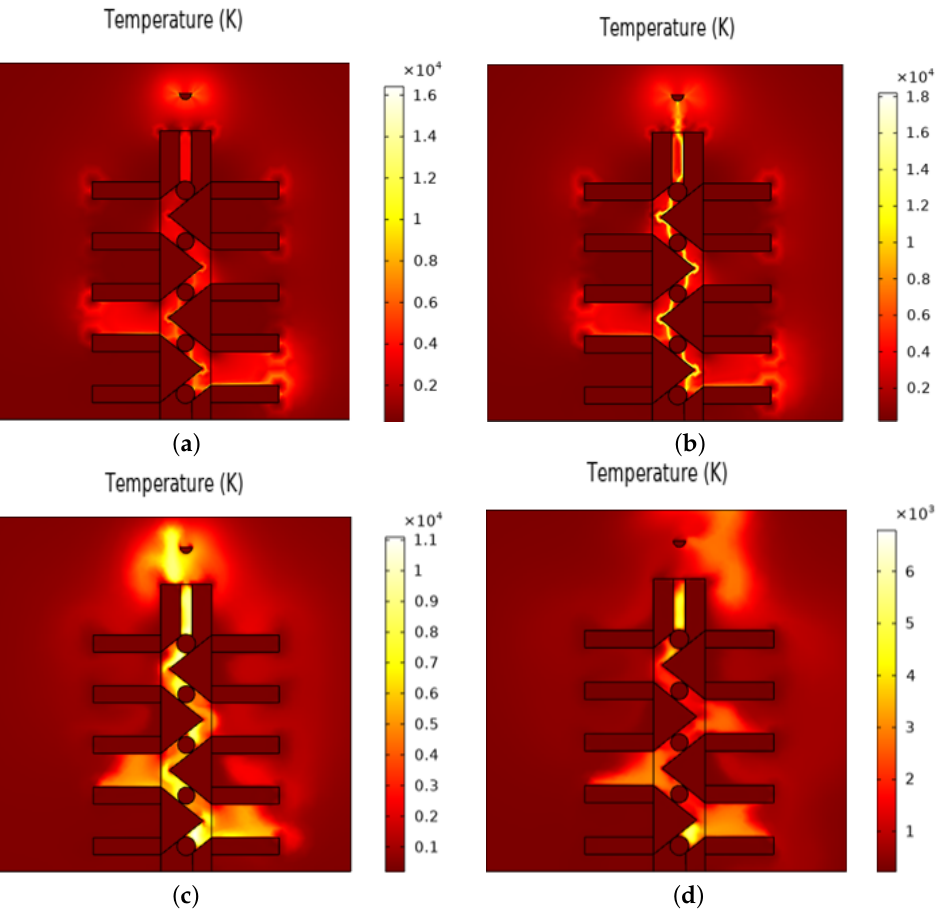
Figure 7. Arc temperature change diagram in the simulation area at different moments: ( a ) t = 10 µ s; ( b ) t = 50 µ s; ( c ) t = 200 µ s; ( d ) t = 1000 µ s